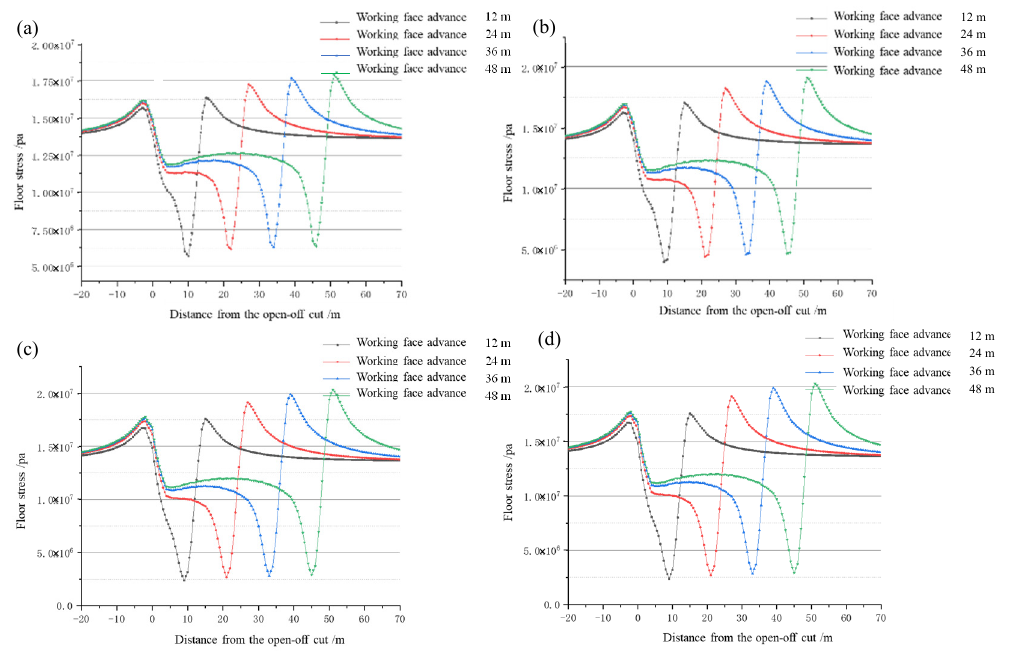
Figure 7. Abutment pressure in front of coal wall of the paste-filling face under different filling steps. ( a ) Filling step distance 1 m, ( b ) Filling step distance 2 m, ( c ) Filling step distance 3 m, ( d ) Filling step distance 4 m.